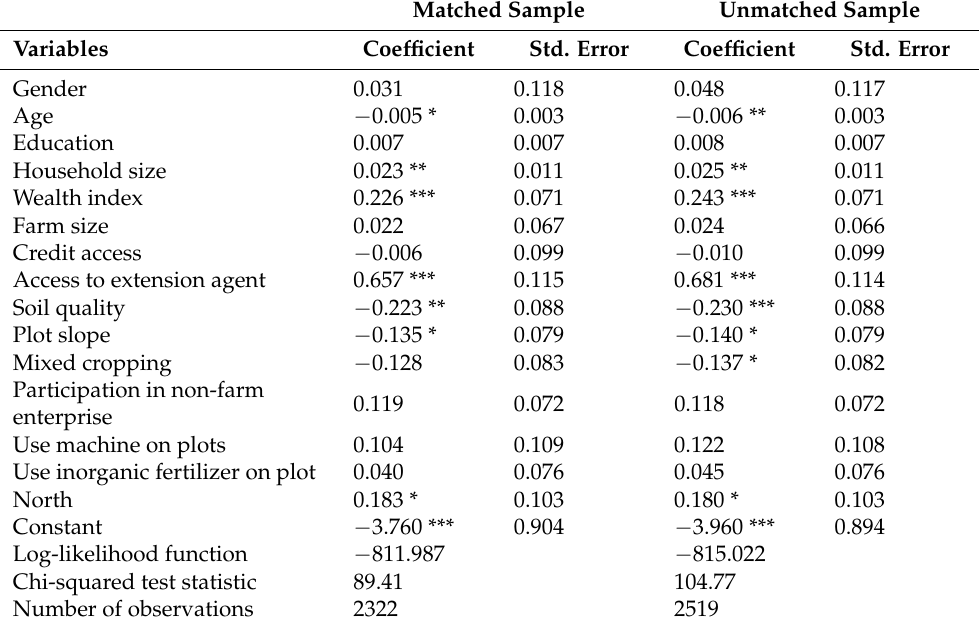
Table 3. Probit estimates of factors that influence improved maize